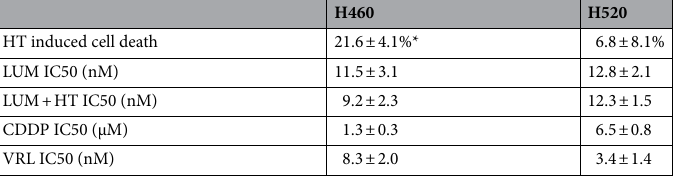
Table 2. Cell viability in the presence and absence of LUM, HT, CDDP, and VRL. Error represents the SD between at least three independent experiments (*p < 0.01 relative to untreated